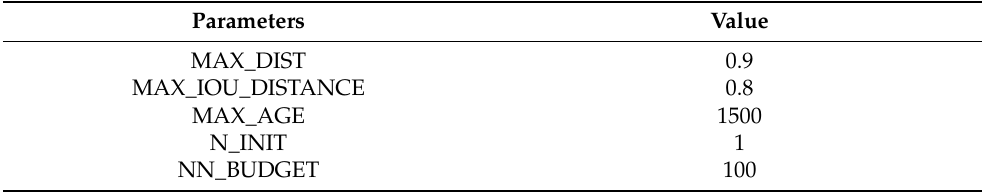
Table 3. Strong-SORT parameters and settings. Parameters